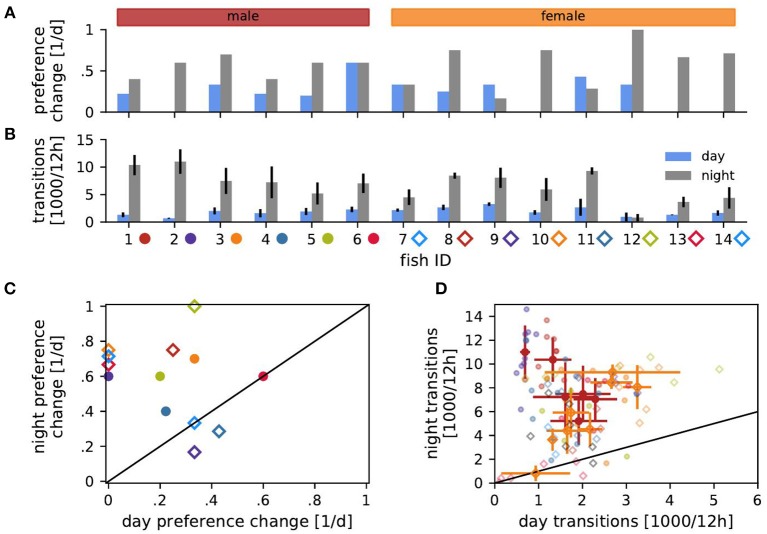
Transitions of habitat preference and between habitats. (A) Probability of changing the preferred habitat from one day (blue) or night (gray) to the next for each fish. (B) Transition rates, i.e., number of detected transitions between habitats per 12 h, averaged over days (blue) or nights (gray) with standard deviation. (C) Probabilities of changing preference of night habitats vs. preference changes of day habitats from (A). (D) Transition rates during the day vs. transition rates at night from (B). Transition counts averaged over days and nights with standard deviation are shown for each male (red) and female (orange). Symbols in (C,D) indicate fish ID as in (B).